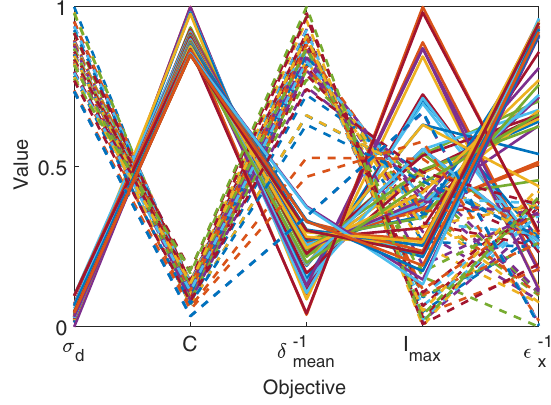
FIG. 3. Parallel coordinate plots of the 50 solutions with the largest energy chirp (dashed lines) and the 50 solutions with the largest current profile factor (solid lines) in the last generation.